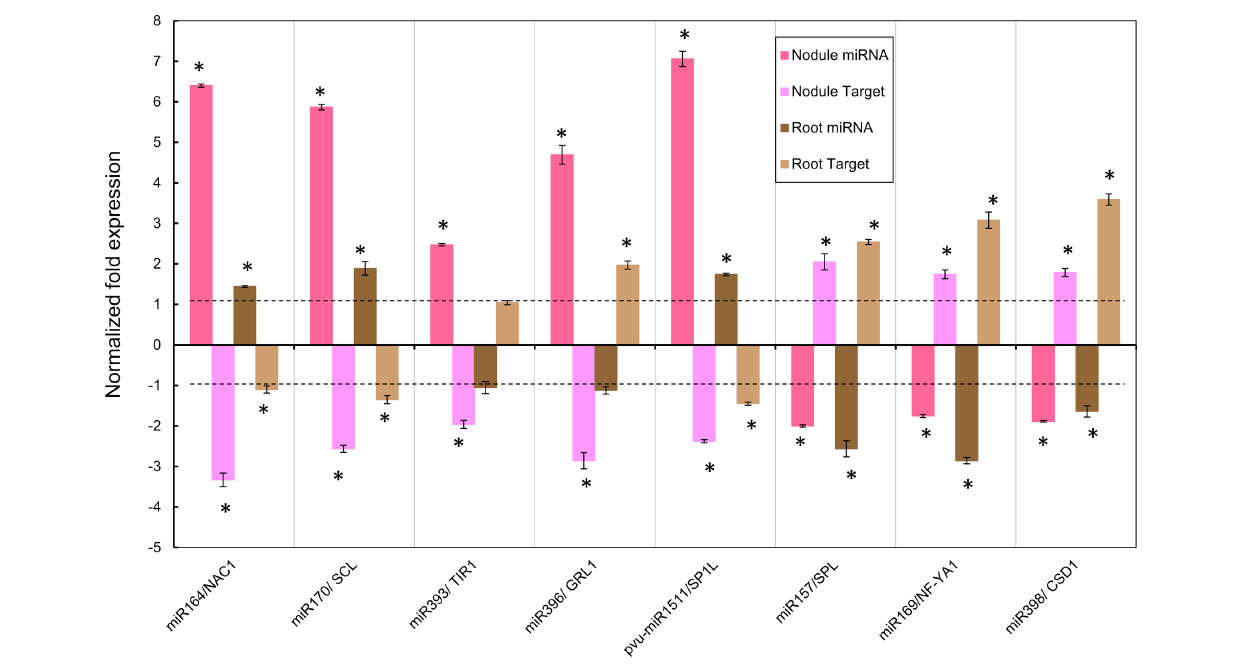
FIGURE 4 | Normalized fold expression levels of selected miRNA/target mRNA nodes in fertilized roots and in SNF nodules of common bean plants under Alt for long period. High Al was added to (12 dpi) R. tropici -inoculated plants with active young nodules or to (12 days) fertilized plants for 7 days before harvesting. miRNAs and target genes expression levels were determined by qRT-PCR in nodules of inoculated plants or in roots of fertilized plants. Values represent the normalized expression ratios (stress:control) given as the average of three biological